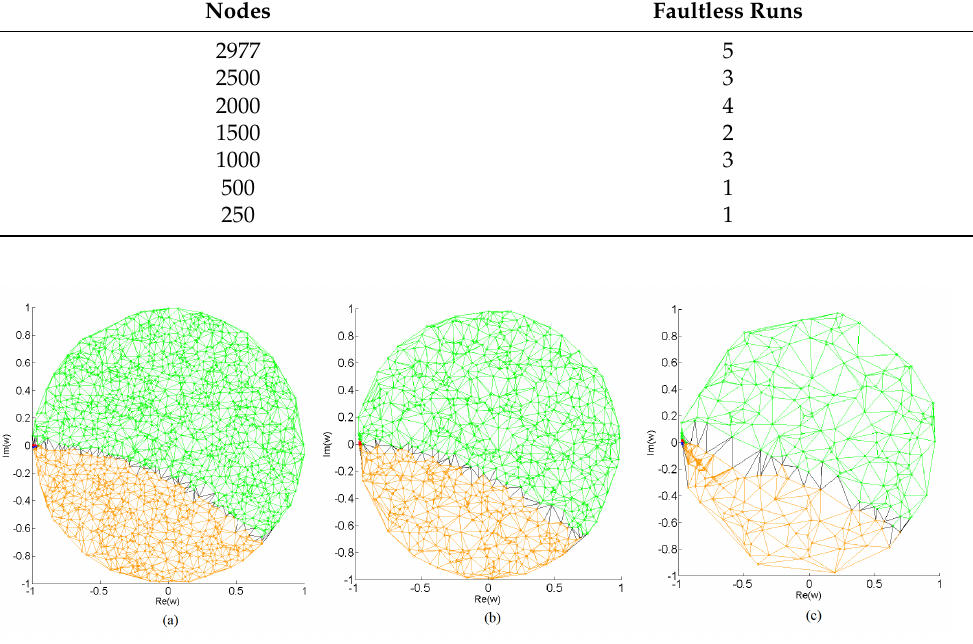
Figure 9. Distribution of nodes with Delaunay’s triangulation for the stability test of a fractional-order digital filter with the use of MGA-WPA. The stability test results are presented for an initial number of nodes set to ( a ) 2000, ( b ) 1000, and ( c ) 250. The “island”-like region with unstable zero is